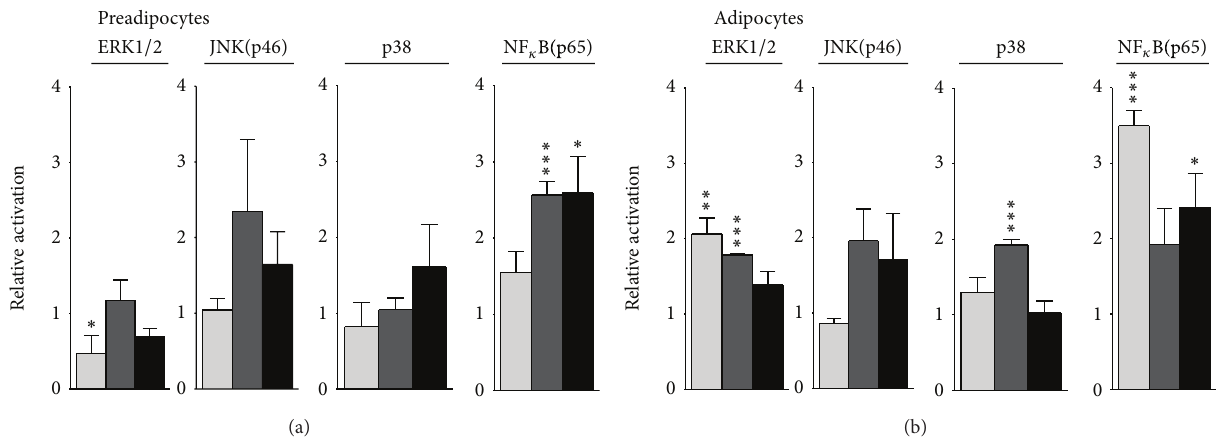
Figure 5: Hsp60 activates proinflammatory signaling in C57BL/6J, NOD, and NZO mouse-derived (pre-)adipocytes. Preadipocytes (a) and mature adipocytes (b) from C57BL/6J (light grey bars), NOD (dark grey bars), and NZO mice (black bars) were exposed to Hsp60 (10 𝜇 g/mL) and after 15min the activation (phosphorylation) of the MAP-kinases ERK1/2, p38, JNK(p46), and the transcription-factor NF 𝜅 B was analyzed by immunoblotting. The results show the activation levels of the signaling molecules relative to their activation in cells incubated in the absence of Hsp60. Data represent means + SEM from three independent experiments. ∗ 𝑃 < 0.05 , ∗∗ 𝑃 < 0.01 ; ∗∗∗ 𝑃 < 0.001 compared to medium control set as